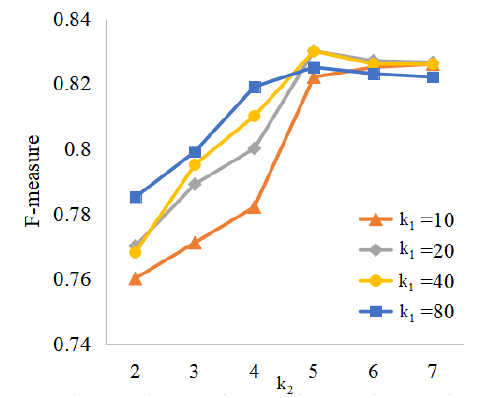
Figure 9. Sensitivity of performance with parameters k 1 and k 2